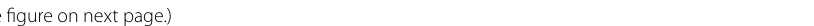
figure on next Fig. 8 Correlation analyses of differential OTUs with serum anti-oxidant indicators ( a ), serum immune indicators ( b ), and hindgut fermentation parameters ( c ). Each cell contains Pearson correlation coefficient and P-value (within brackets). a MDA, malondialdehyde; SOD, superoxide dismutase; GSH-Px, glutathione peroxidase; CAT, catalase; T-AOC, total antioxidant capacity. b Ig, immunoglobulin; IL, interleukin. c AA, acetic acid; PA, propionic acid; IBA, isobutyric acid; BA, butyric acid; IVA, isovaleric acid; VA, valeric acid; NH 3 -N, ammoniacal